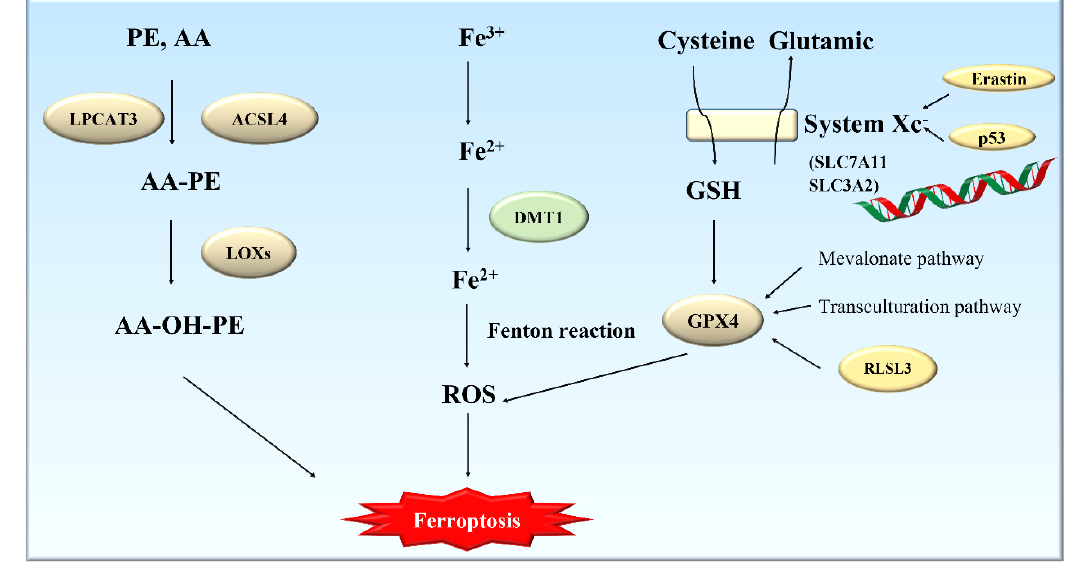
Figure 1. Molecular mechanisms and signaling pathways of